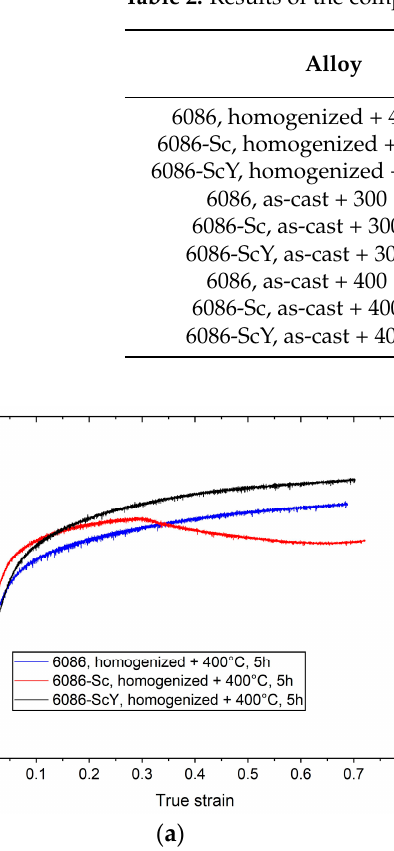
Table 2. Results of the compression tests.